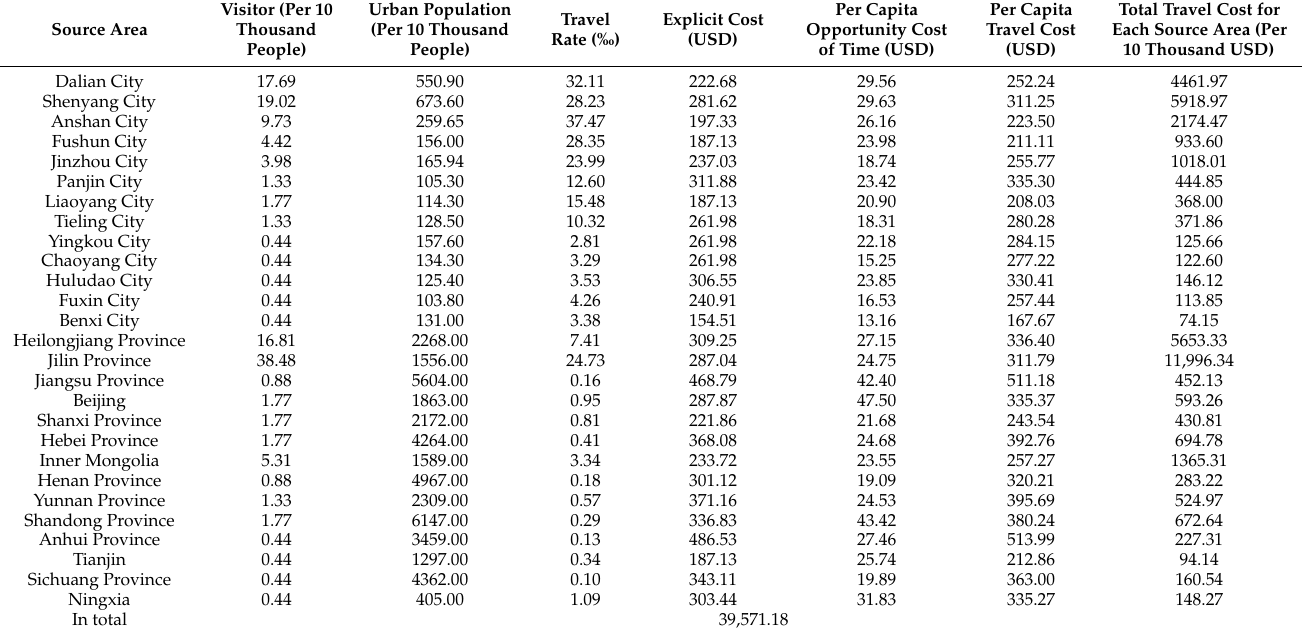
Table 2. Tourist travel rate and travel cost of each tourist source area of Changhai County in 2019.